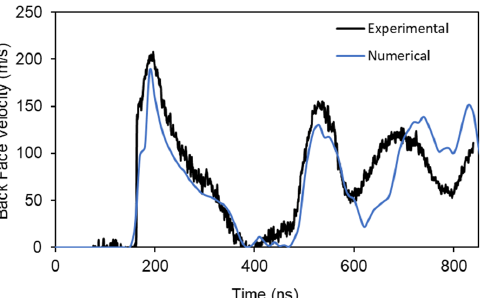
Figure 7. Comparison between the predicted and experimental back face velocity profiles for alu- minum 2024. aluminum